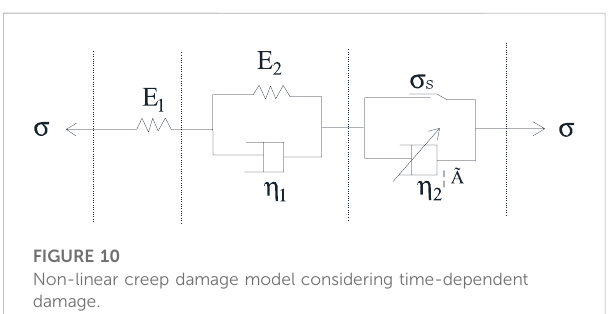
FIGURE 10 Non-linear creep damage model considering time-dependent